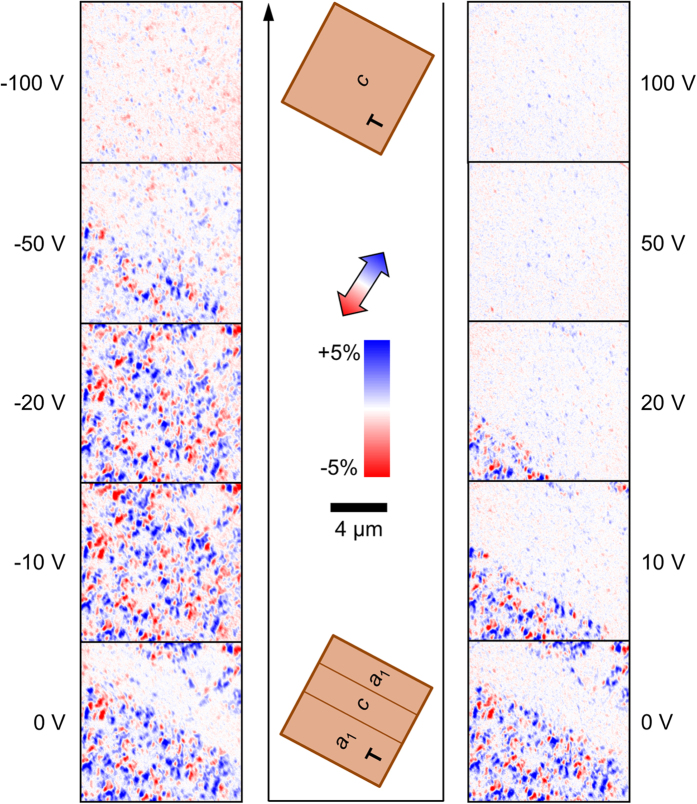
Magnetoelectric effect by XMCD.XMCD images at 385 K at several voltages V during a stepwise sweep from +100 V to −100 V. The black arrow indicates the order of images in time. Sketches show the expected BTO domains for large and small |V|.